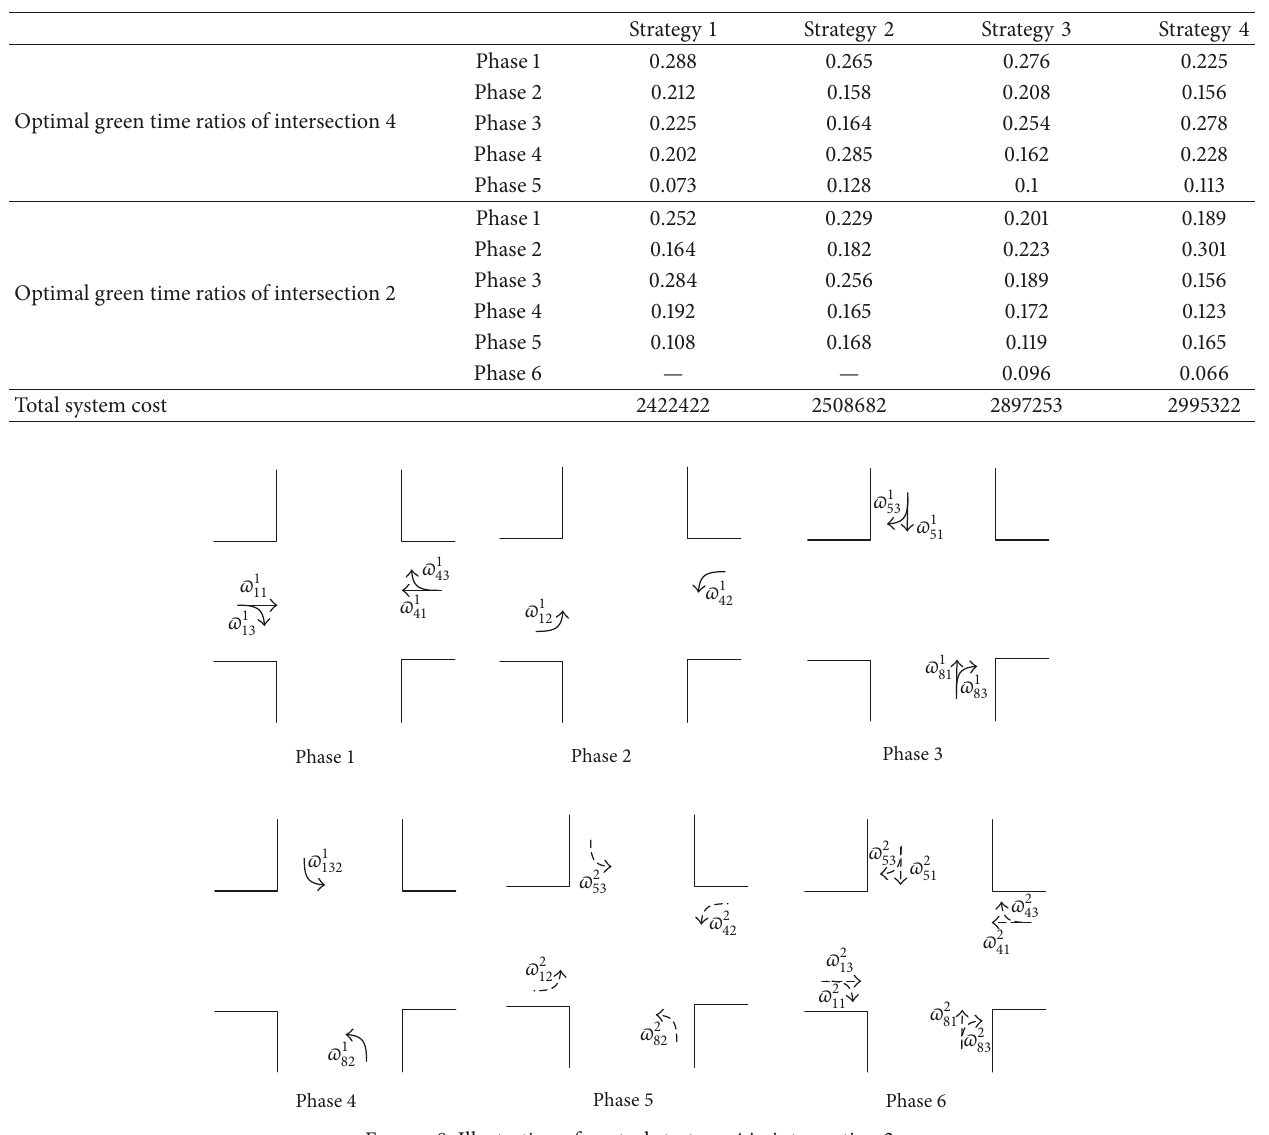
Table 2: Optimal green time ratios under different strategies.